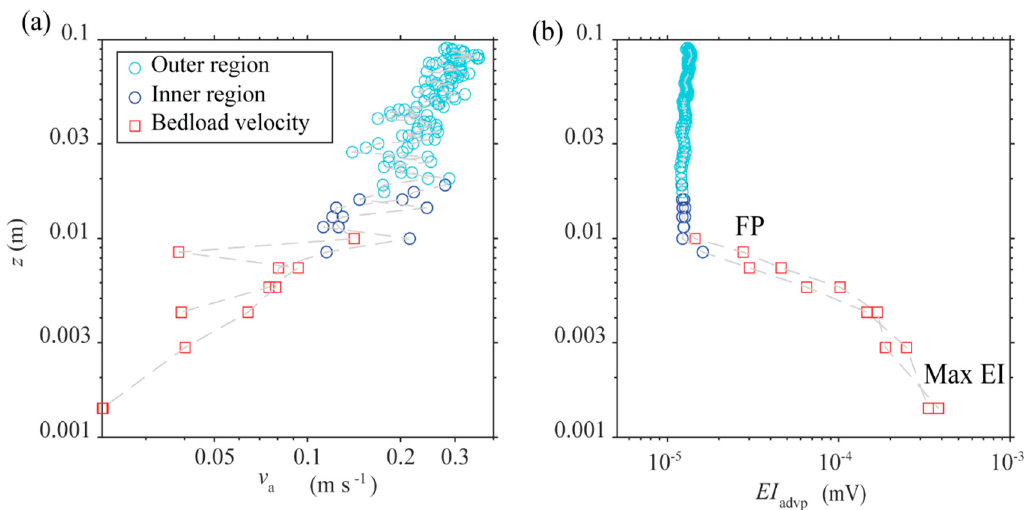
Figure 4. ( a ) Full velocity profile of ADVP; ( b ) echo intensity profile of ADVP.